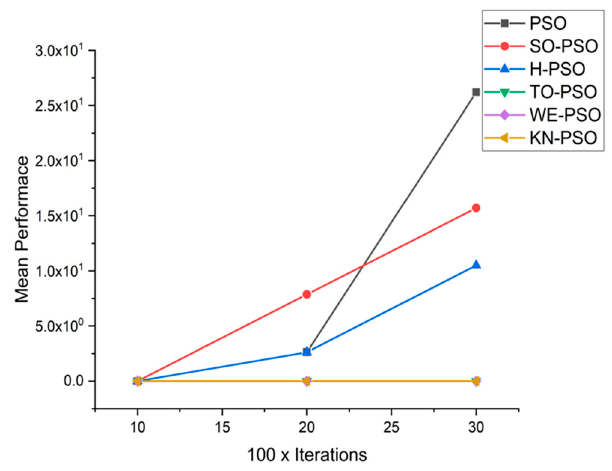
Figure 10. Convergence curve on fn4.